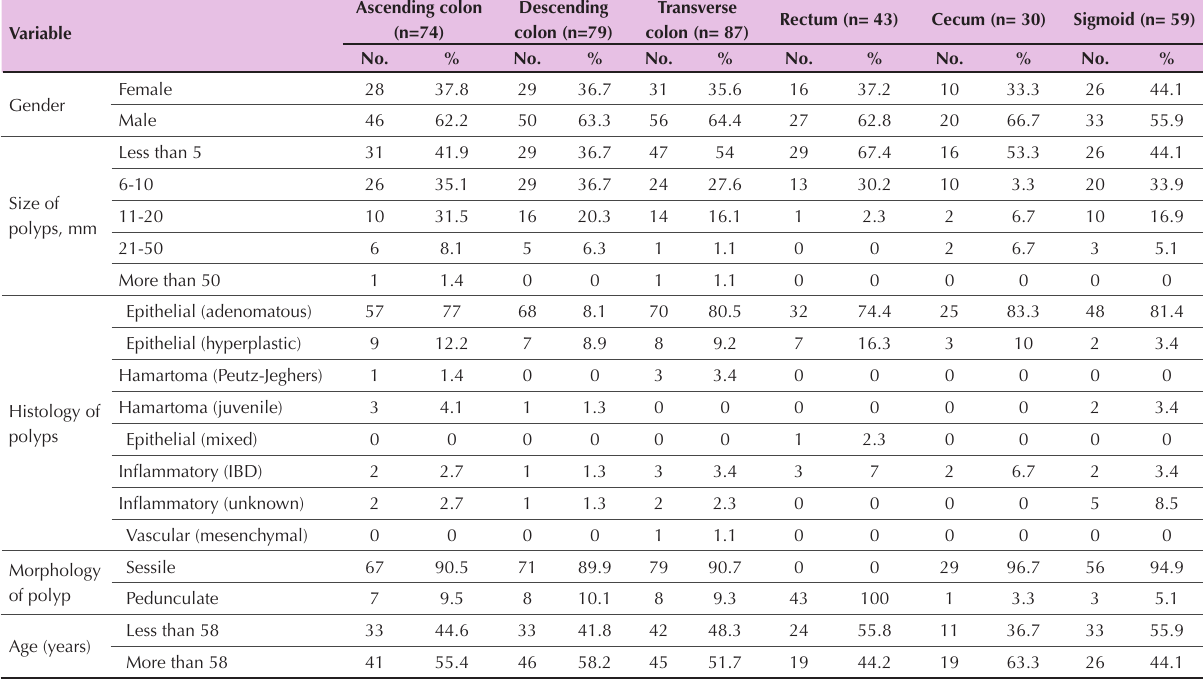
Table 3. Histologic and morphologic details of polyps based on location